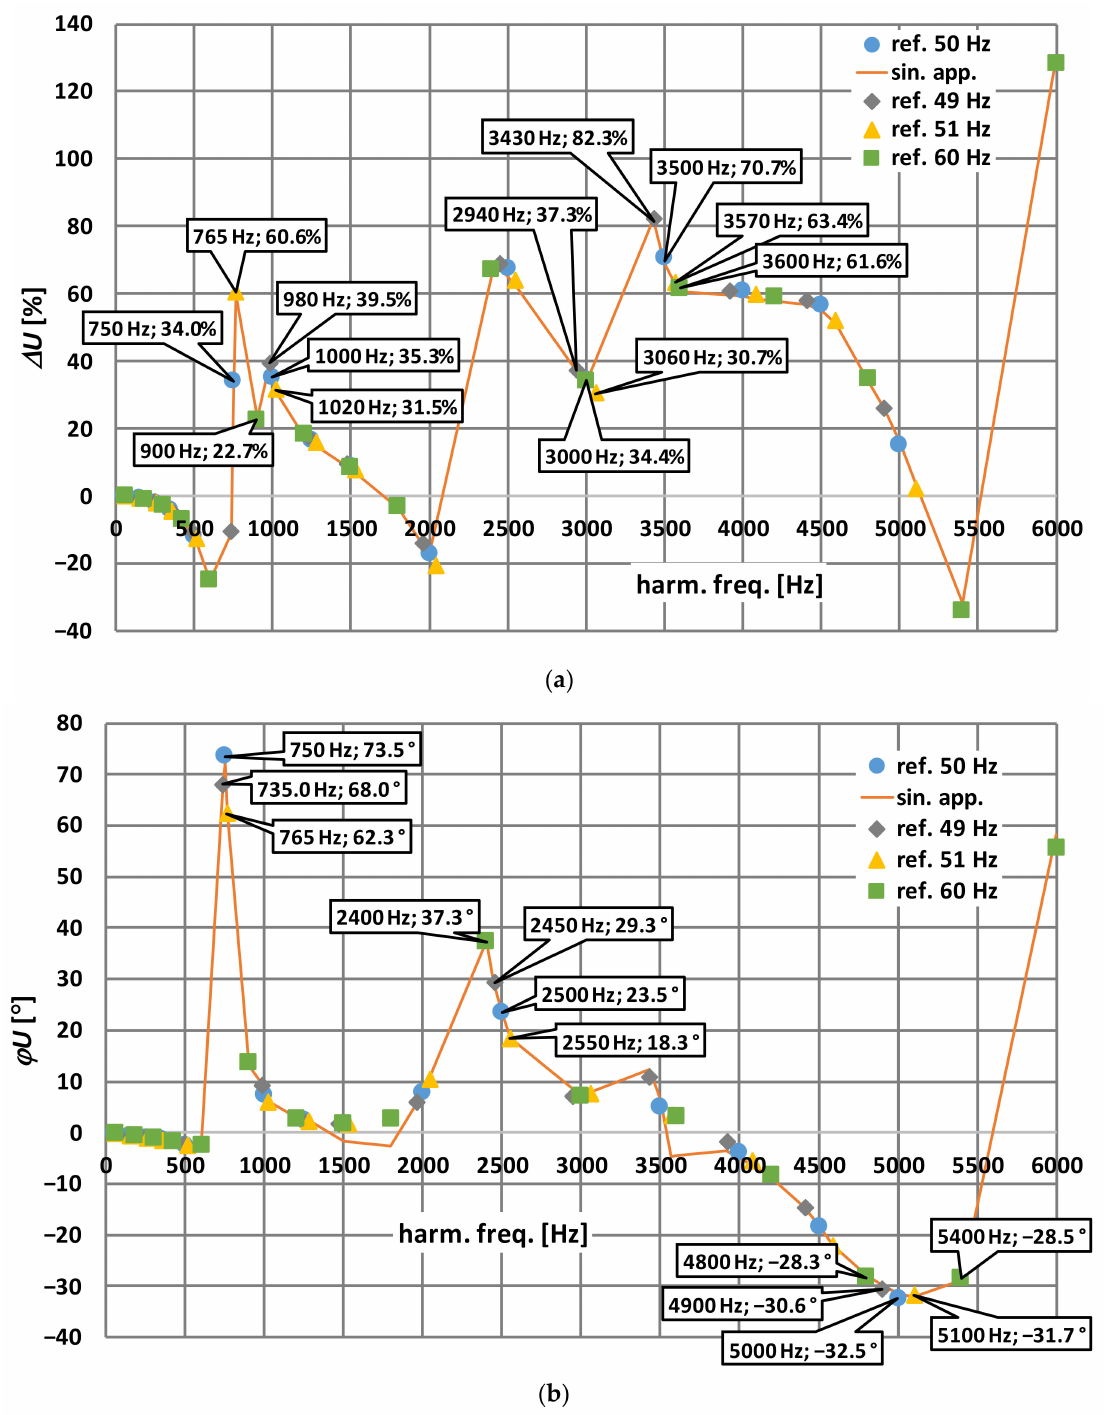
Figure 3. Comparison of the transformation accuracy of the 15 kV VT for harmonics of the non-sinusoidal and sinusoidal primary voltage: ( a ) voltage error, ( b ) phase